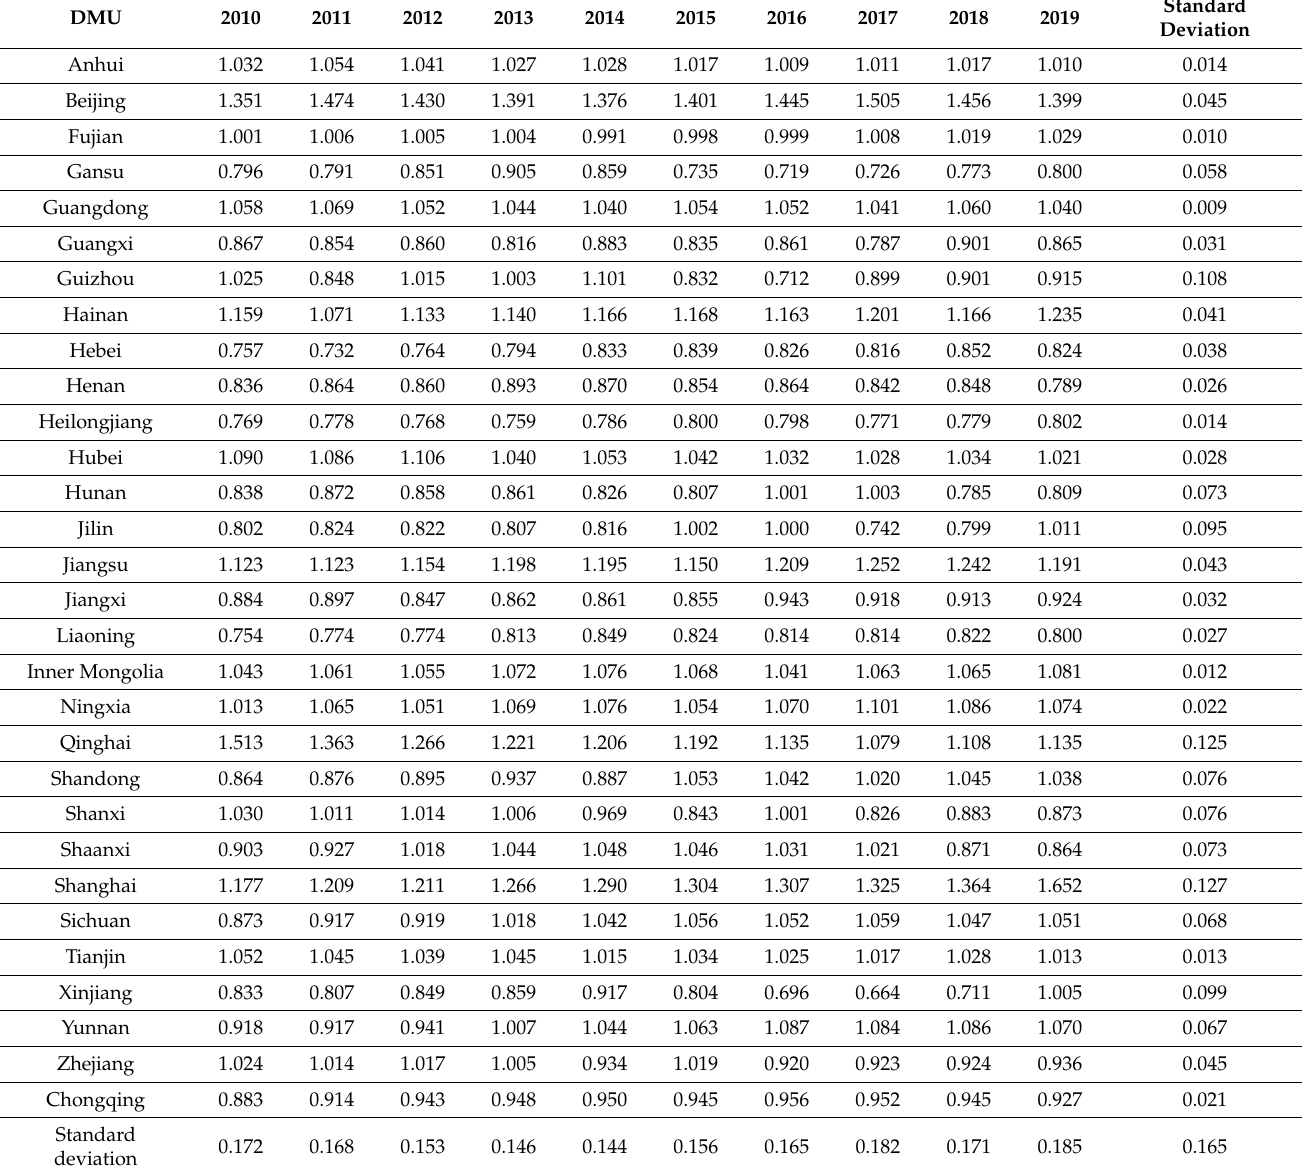
Table 3. Environmental performance values of the power industry by region from the year 2010 to